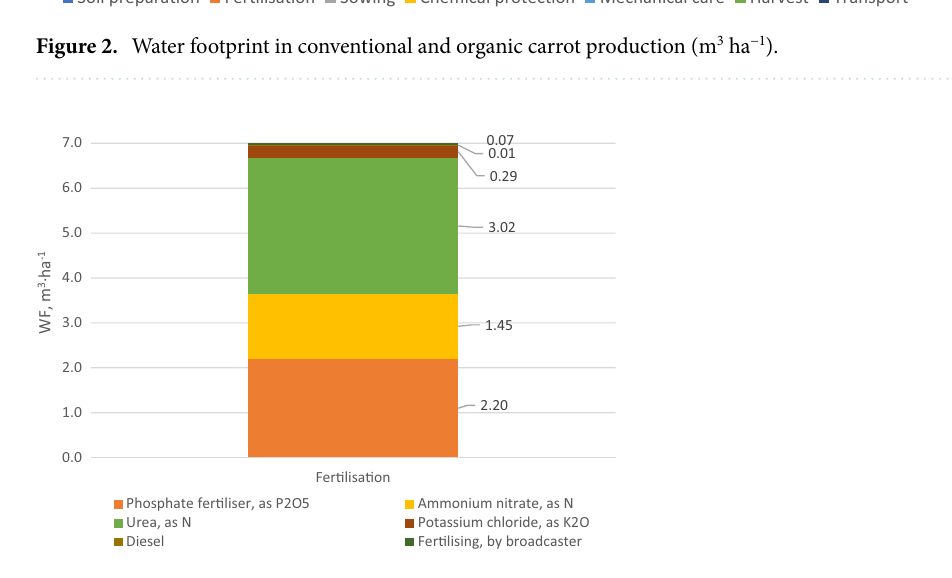
Figure 3. Water footprint related to carrot fertilization in conventional production (m 3 ha −1